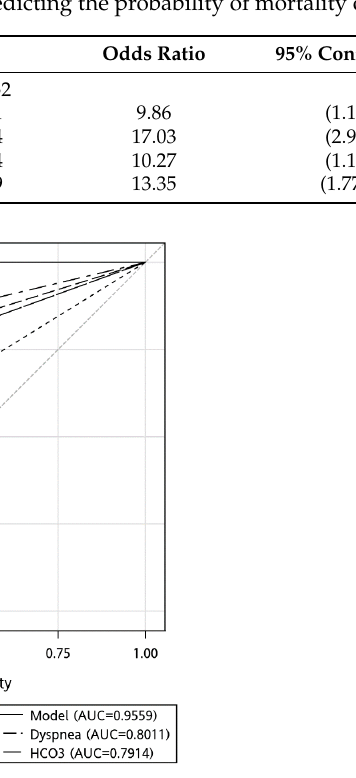
The drugs used in the mortality group were as below. The patients of single-use of drugs were morphine ( n = 5), methamphetamine ( n = 4), meta-chlorophenyl piperazine ( n = 2), and 4-chloromethcathinone ( n = 1). The patients of multiple use of drugs were meth-